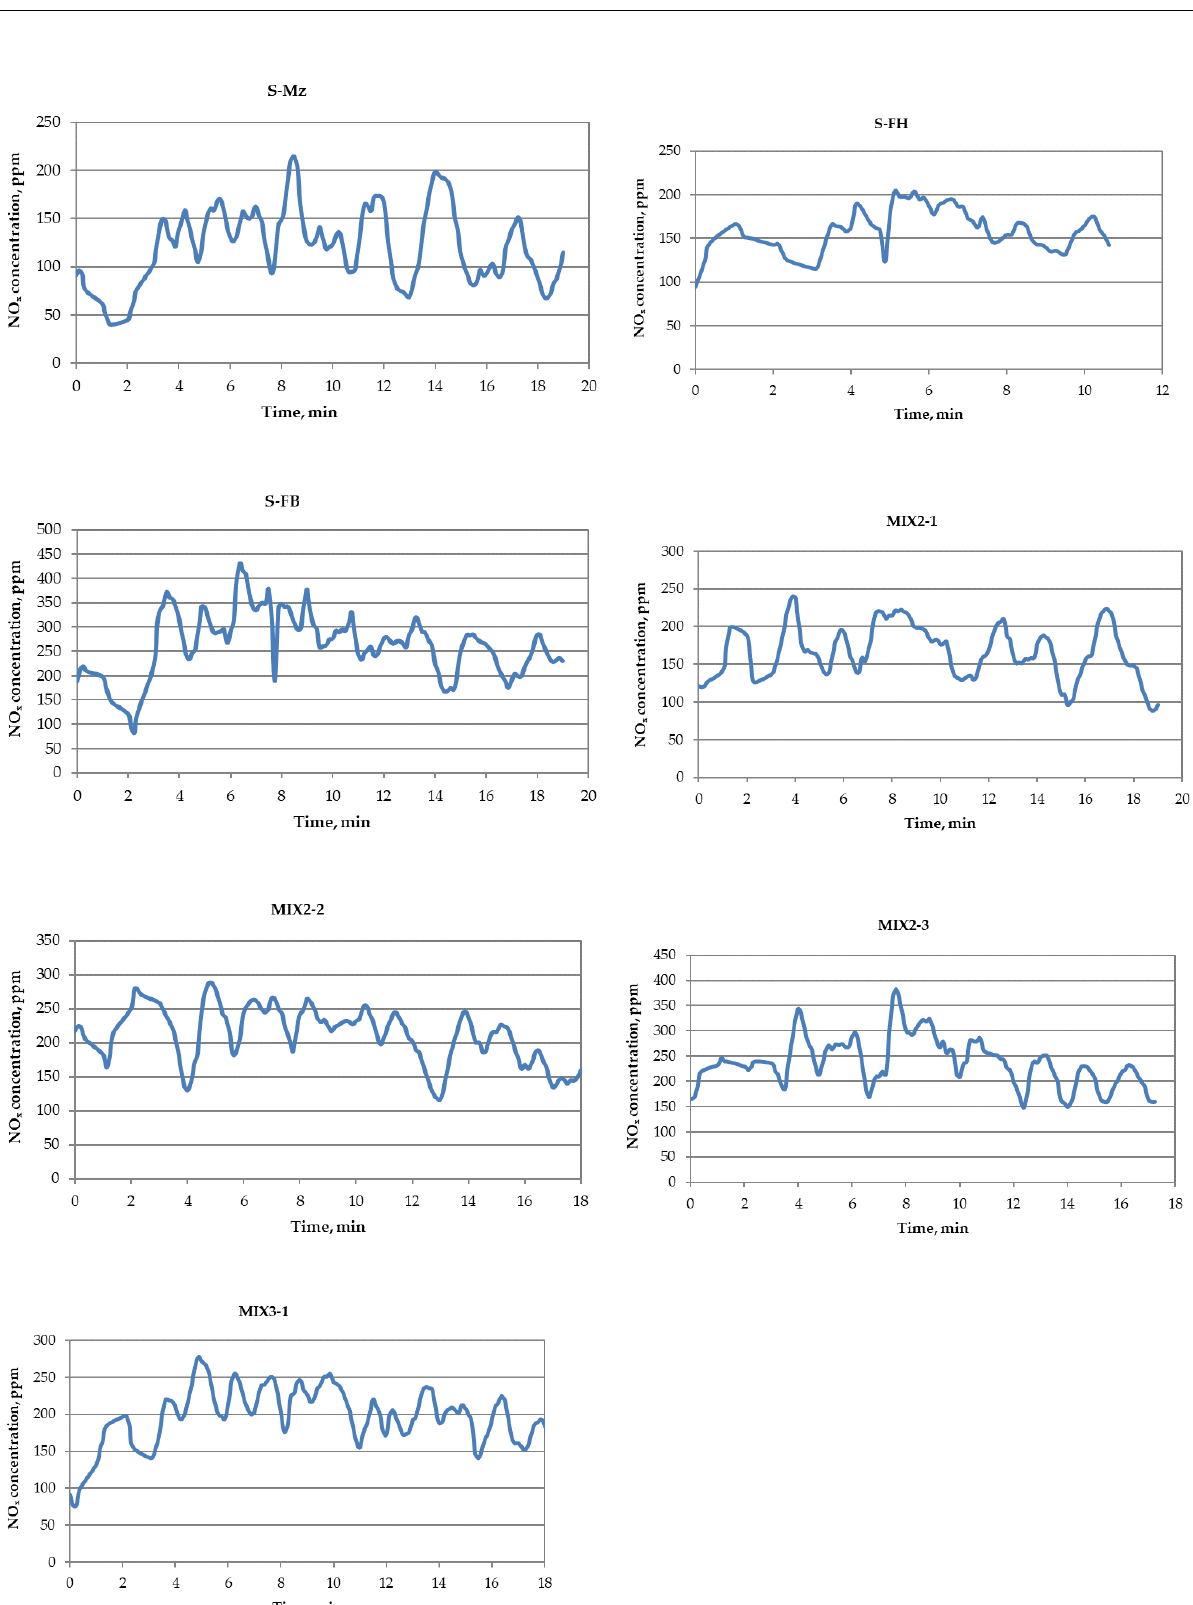
Figure 6. NO x concentrations during combustion of pellets.